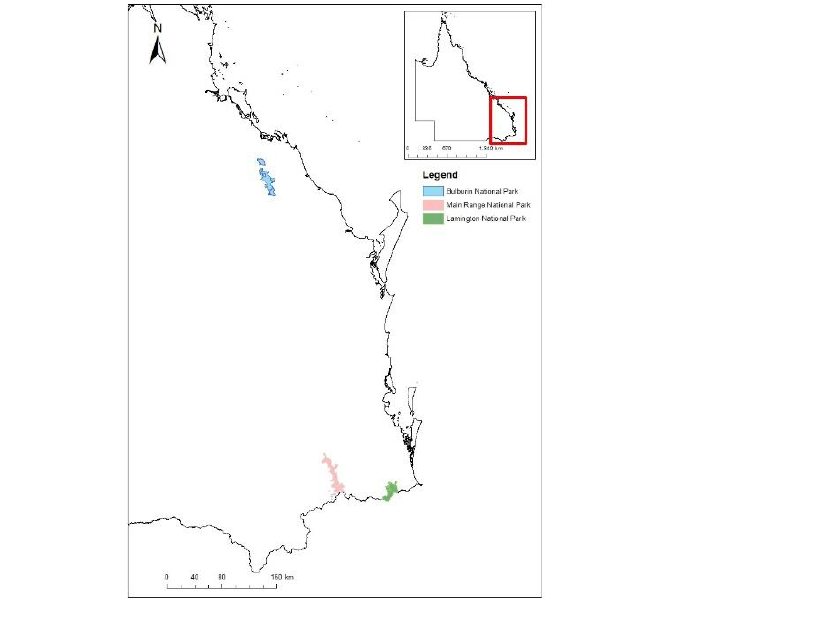
Figure 1. Site Locations: Bulburin NP (blue); Main Range NP (pink); Lamington NP